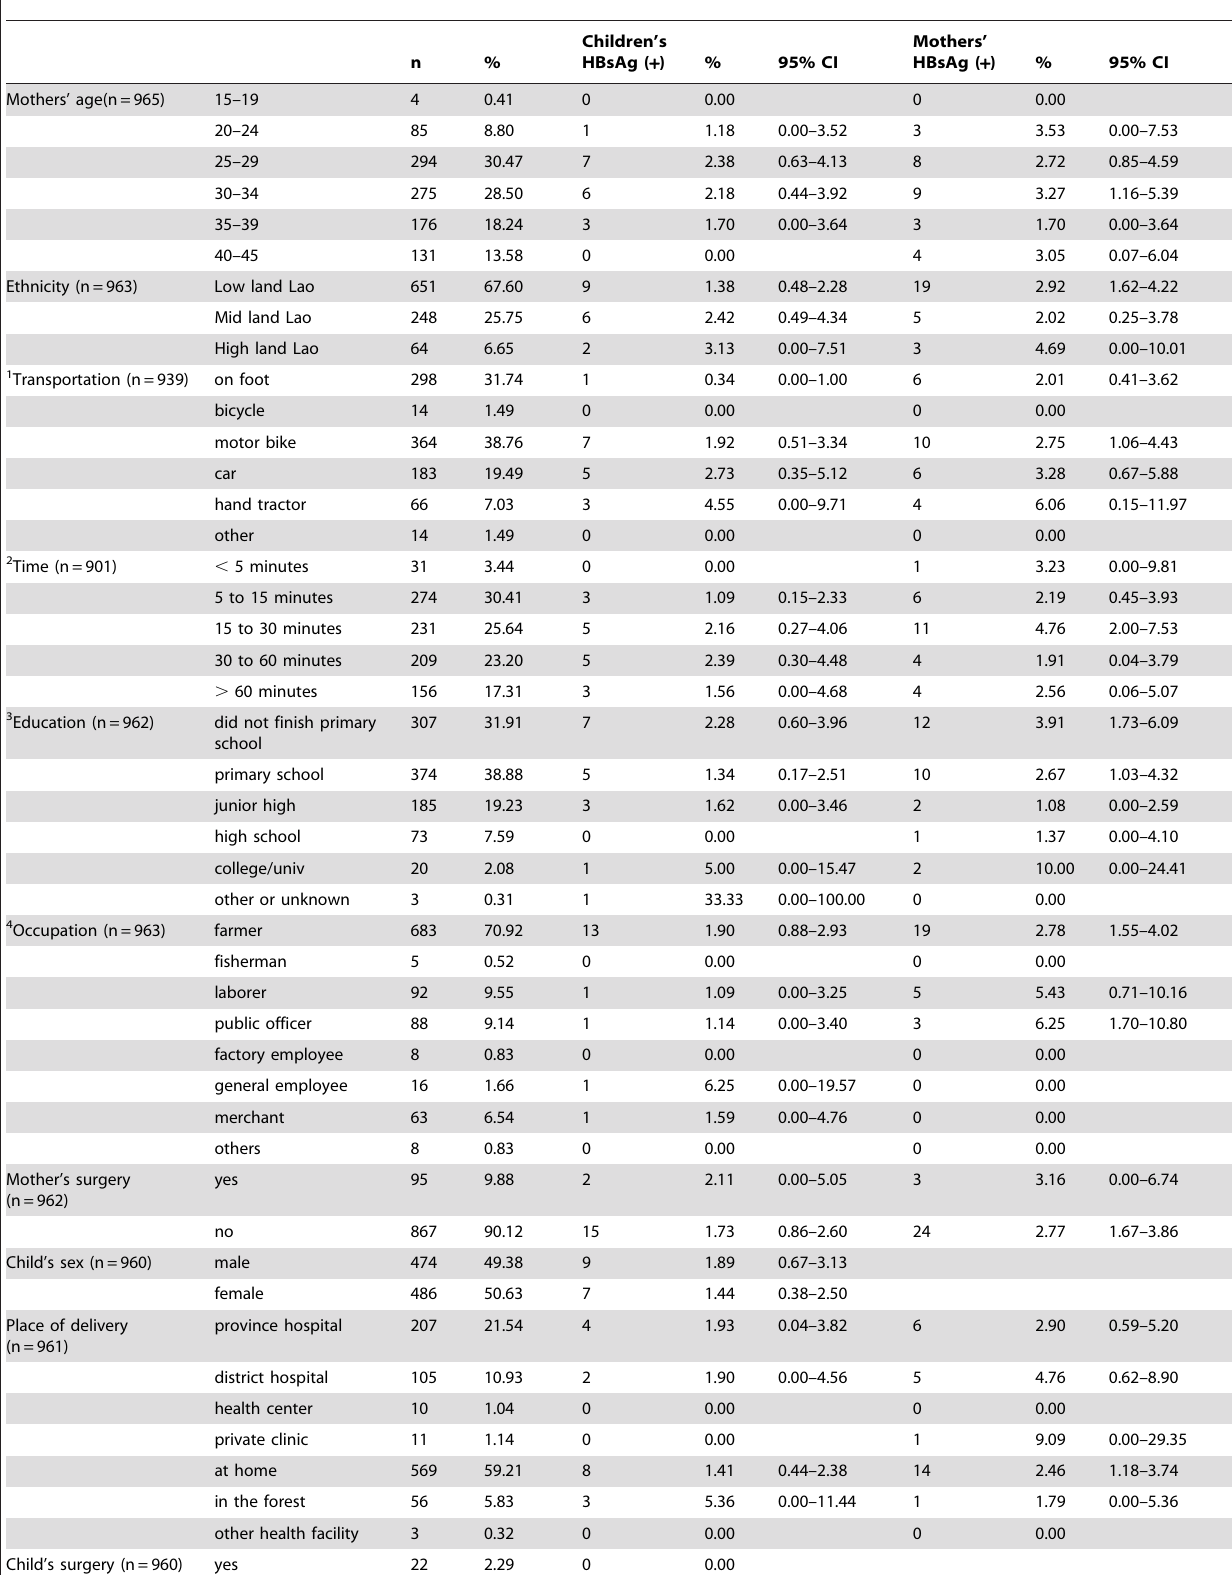
Table 1. HBsAg prevalence among children (5 to 9 years old) and mothers (15 to 45 years old) in Lao PDR by selected background